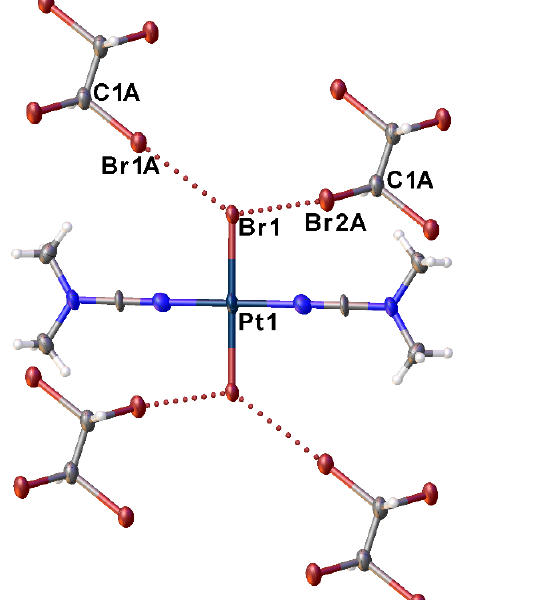
Table 1. Parameters of XB in adducts 1·tbe and 2·tbe (X = 1, 2).